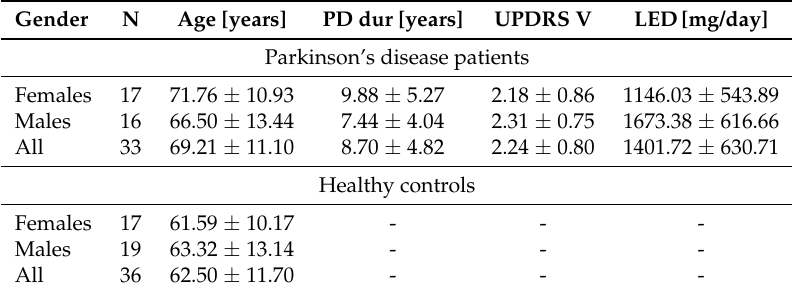
Table 2. Demographic and clinical data of the enrolled participants.